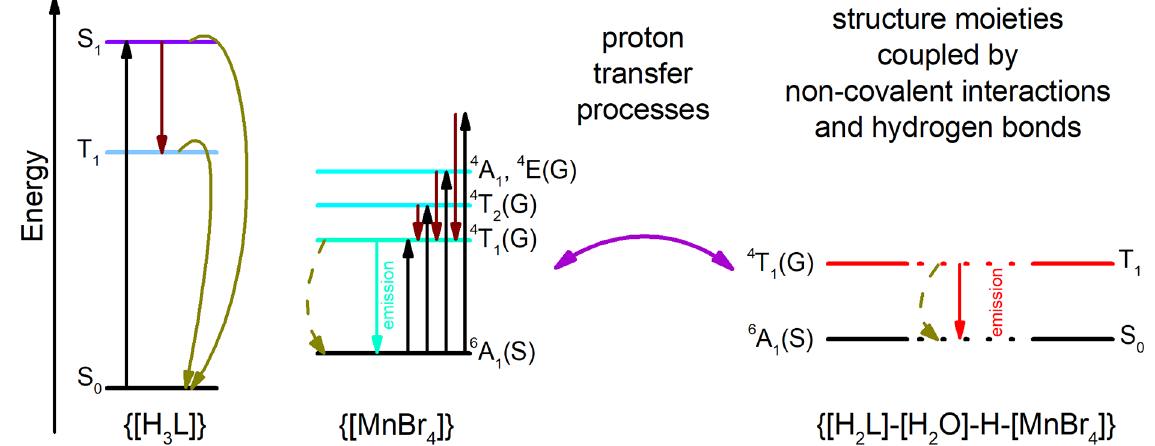
: absorption, Figure 4. Representation of energy transfer and emission processes in 1 ( ▬ : absorption, ▬ : internal : internal Figure 4. Representation of energy transfer and emission processes in 1 ( ▬ : absorption, ▬ : internal Figure 4. Representation of energy transfer and emission processes in 1 ( ▬ : absorption, ▬ : internal Figure 4. Representation of energy transfer and emission processes in 1 ( ▬ : absorption, ▬ : internal Figure 4. Representation of energy transfer and emission processes in 1 ( ▬ : absorption, ▬ : internal conversion and intersystem crossing transition, ▬ : emission of an uncoupled {[MnBr 4 ]} moiety, ▬ : conversion and intersystem crossing transition, ▬ : emission of an uncoupled {[MnBr 4 ]} moiety, ▬ : conversion and intersystem crossing transition, ▬ : emission of an uncoupled {[MnBr 4 ]} moiety, ▬ : conversion and intersystem crossing transition, : emission of an uncoupled {[MnBr 4 ]} moiety, Figure 4. Representation of energy transfer and emission processes in 1 ( ▬ : absorption, ▬ : internal conversion and intersystem crossing transition, ▬ : emission of an uncoupled {[MnBr 4 ]} moiety, ▬ : conversion and intersystem crossing transition, ▬ : emission of an uncoupled {[MnBr 4 ]} moiety, ▬ : Figure 4. Representation of energy transfer and emission processes in 1 ( ▬ : absorption, ▬ : internal proton transfer processes, ▬ : emission of a coupled {[H 2 L]-[H 2 O]}-H-[MnBr 4 ]} moiety, and ▬ : proton transfer processes, ▬ : emission of a coupled {[H 2 L]-[H 2 O]}-H-[MnBr 4 ]} moiety, and ▬ : proton transfer processes, ▬ : emission of a coupled {[H 2 L]-[H 2 O]}-H-[MnBr 4 ]} moiety, and ▬ : proton transfer processes, ▬ : emission of a coupled {[H 2 L]-[H 2 O]}-H-[MnBr 4 ]} moiety, and ▬ : proton transfer processes, ▬ : emission of a coupled {[H 2 L]-[H 2 O]}-H-[MnBr 4 ]} moiety, and ▬ : conversion and intersystem crossing transition, ▬ : emission of an uncoupled {[MnBr 4 ]} moiety, ▬ : conversion and intersystem crossing transition, ▬ : emission of an uncoupled {[MnBr 4 ]} moiety, ▬ : non-radiative relaxation). non-radiative relaxation). non-radiative relaxation). non-radiative relaxation). proton transfer processes, ▬ : emission of a coupled {[H 2 L]-[H 2 O]}-H-[MnBr 4 ]} moiety, and ▬ : proton transfer processes, ▬ : emission of a coupled {[H 2 L]-[H 2 O]}-H-[MnBr 4 ]} moiety, and ▬ : non-radiative relaxation). non-radiative